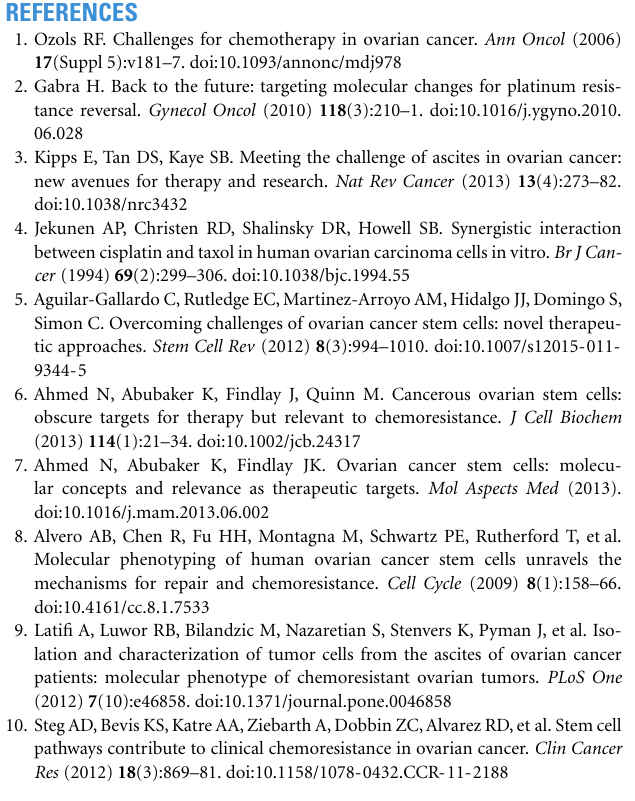
Figure S1 |Tumor volume in mice treated with a single dose of paclitaxel . (A) Representative image of subcutaneous tumors in control and paclitaxel-treated mice. (B) Fold change in tumor volume (mm 3 ) at the end of the study (7days post treatment) was standardized to initial tumor volume prior to receiving paclitaxel treatment. Data were obtained from n = 3 mice in each group. No significant difference between treatment groups was observed. Figure S2 | Immunohistochemistry images of CD117, Oct4, and CA125 staining in HEY xenografts derived from mice treated with or without a single dose of paclitaxel .Tumor sections were stained with antibodies specific for CD117, Oct4, and CA125 as described in the Section “Materials and Methods.” Average DAB intensity and proportion of staining for CD117, Oct4, and CA125 in mouse tumors was standardized to a negative control.The experiment was performed on three independent xenografts from each group. Significant intergroup variations are indicated by *** p < 0.001. Magnification 200 × , scale bar = 10 µ M. Figure S3 |The mRNA expression of housekeeping gene 18S in xenografts generated from subcutaneous transplantation of HEY cells into mice administered with or without paclitaxel, CYT387, or pac + CYT . mRNA from xenografts generated from the control group and treatment groups was extracted, cDNA was prepared, and q-PCR for 18S was performed as described in the Section “Materials and Methods.”The experiments were performed using four independent samples in